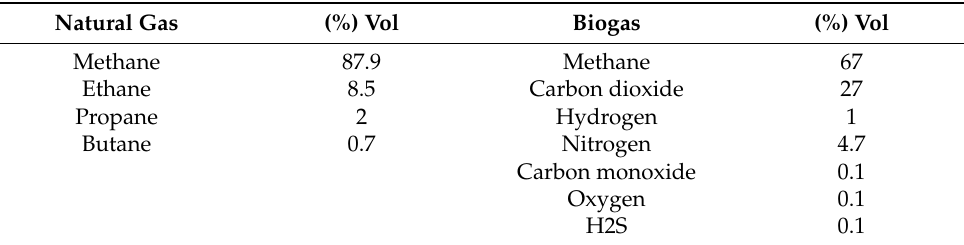
Table 1. Natural gas composition and standard biogas composition (mole percent).